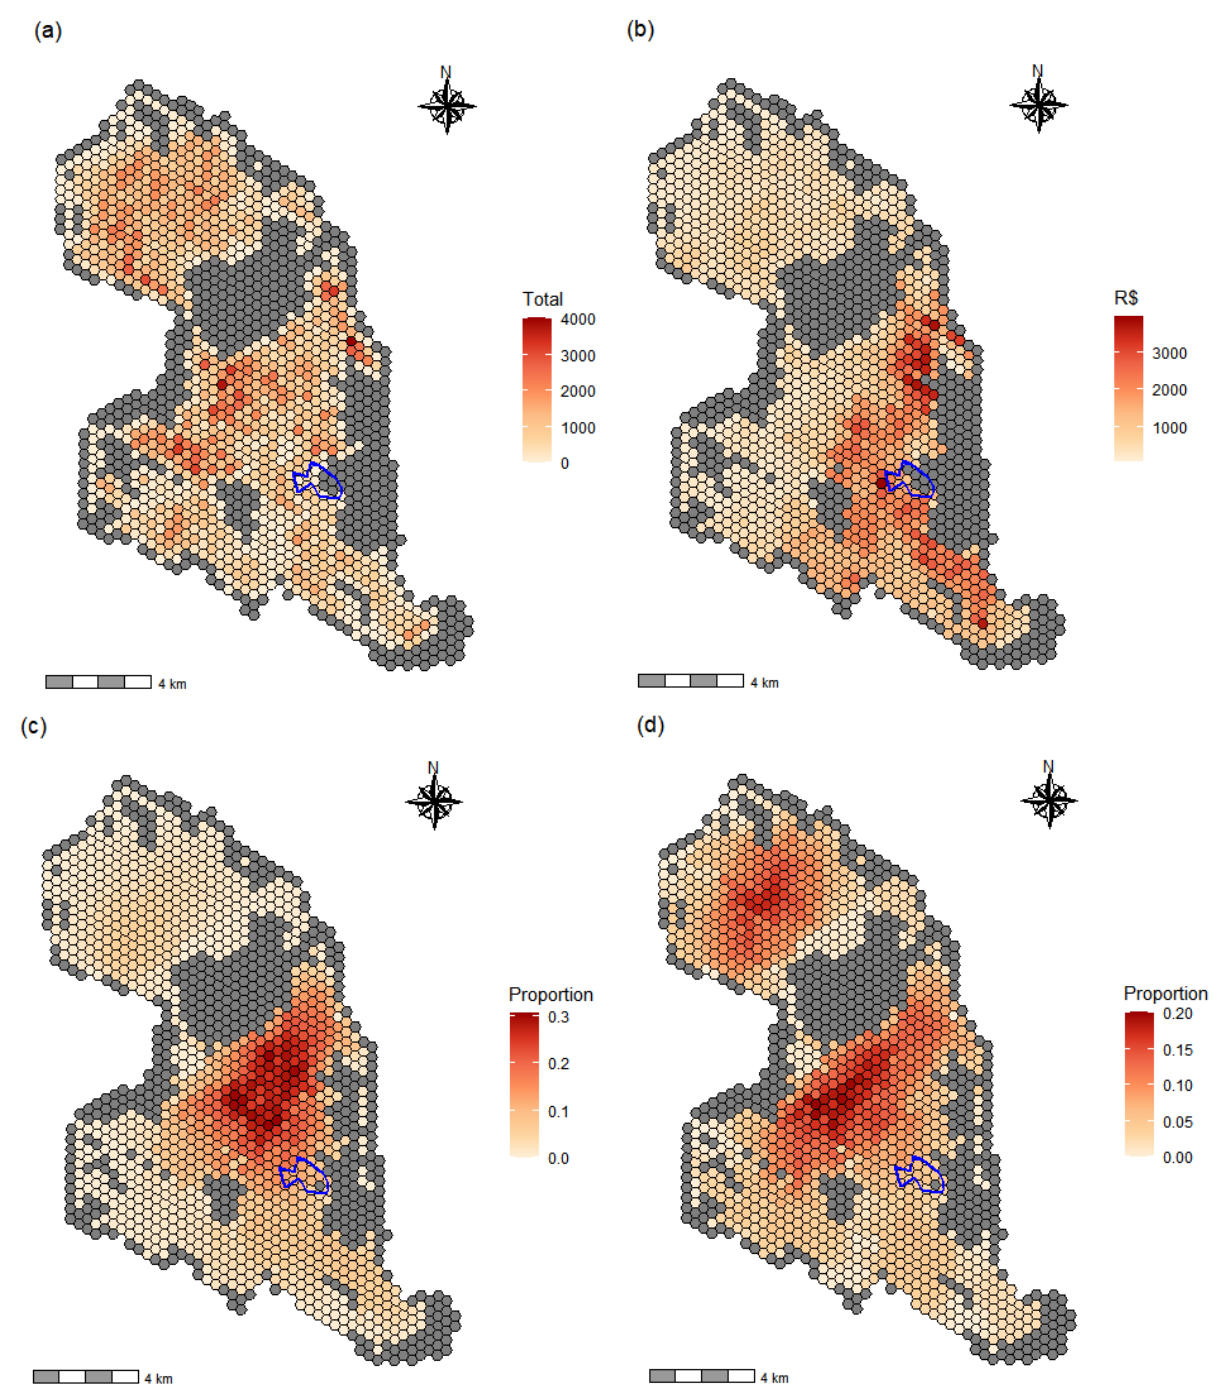
Figure 9. Socioeconomic characteristics and access to opportunities using bicycles: ( a ) Total population; ( b ) Household income per capita; ( c ) Accessible opportunities within a 15-min by cycling—employment; ( d ) Accessible opportunities within a 15-min by cycling—public schools. In blue, the limits of the central campus of UFRN. Source: